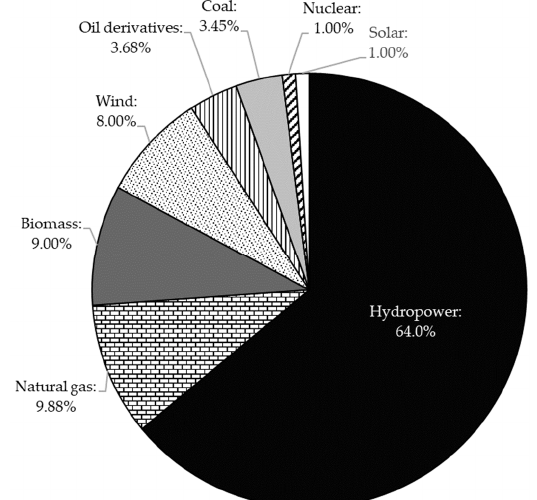
Figure 1. Brazilian installed capacity of electricity generation in 2017: relative distribution by source.